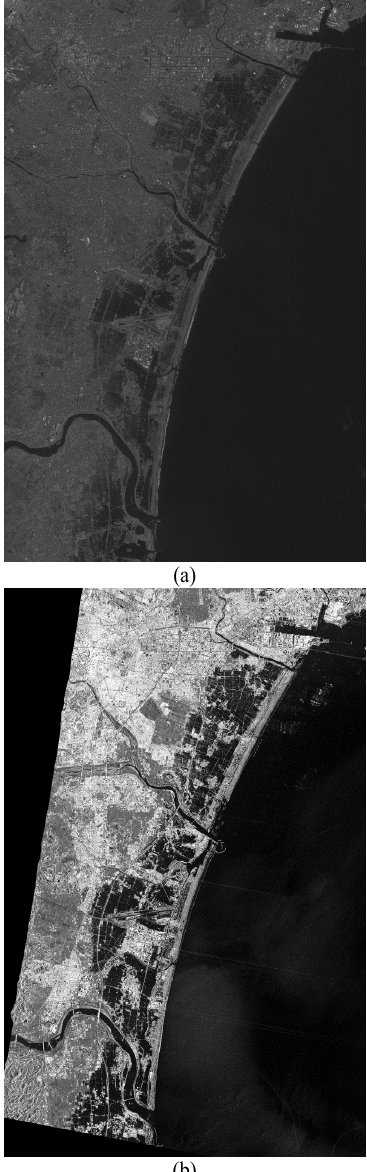
Figure 9. (a) Optical image over the study area taken from FORMOSAT-2 on March 29, 2011. (b) SAR image over the study area taken on March 12, 2011 from TSX. Flooding from the tsunami can be seen in dark area.